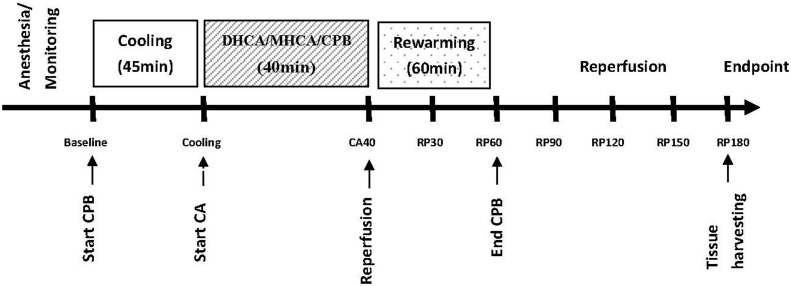
Experimental protocol.CA40, circulatory arrest for 40 min; RP30, reperfusion for 30 min; RP60, reperfusion for 60 min; RP 90, reperfusion for 90 min; RP 120, reperfusion for 120 min; RP 150, reperfusion for 150 min; and RP 180, reperfusion for 180 min.